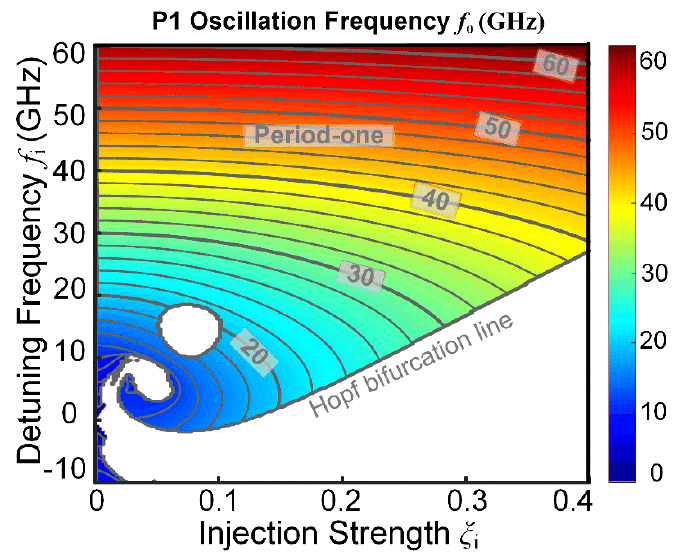
Figure 3. Dependence of the P1 oscillation frequency f o on detuning frequency and injection strength [23].